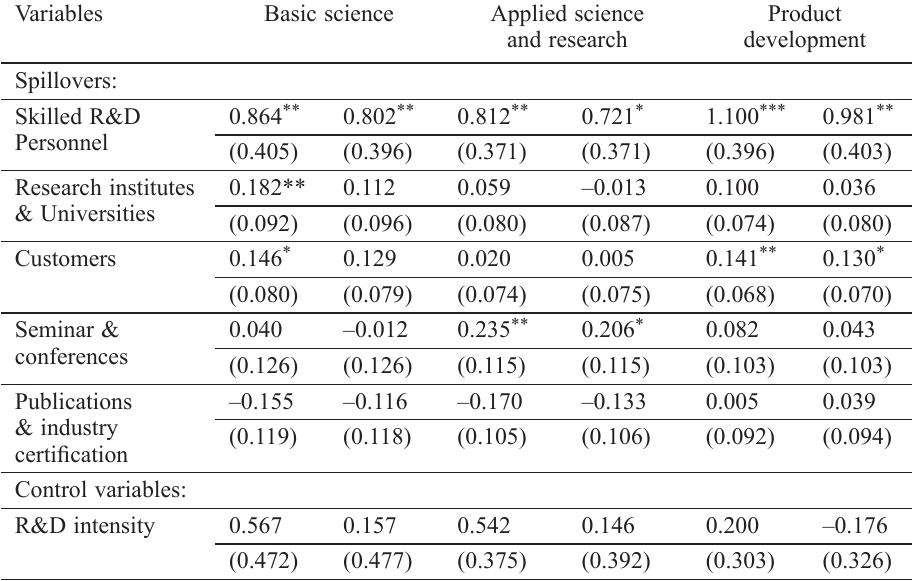
Table 3. Probit regressions: International spillovers and knowledge acquisition Variables Basic science Applied science and research